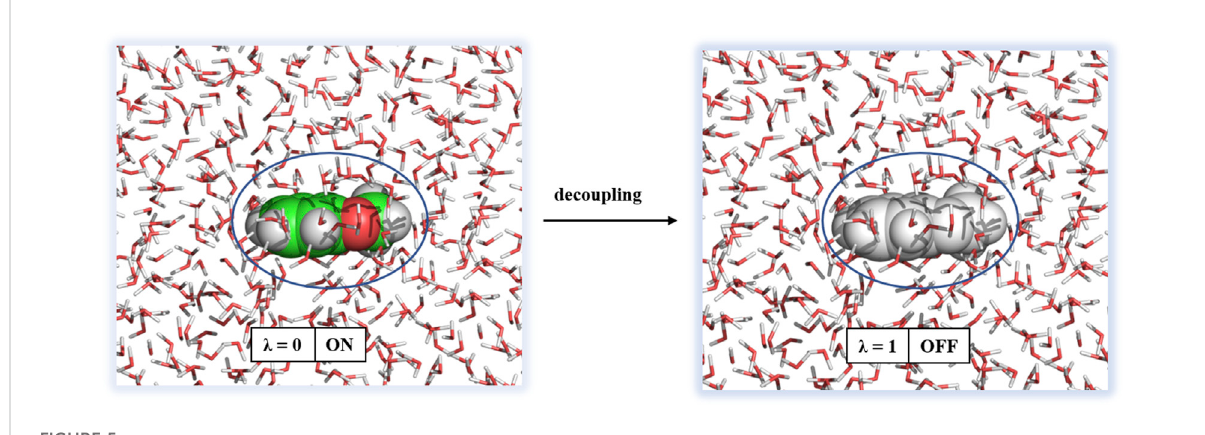
FIGURE 5 Decoupling of a ligand from solvation. Water molecules are shown in sticks and ligand as